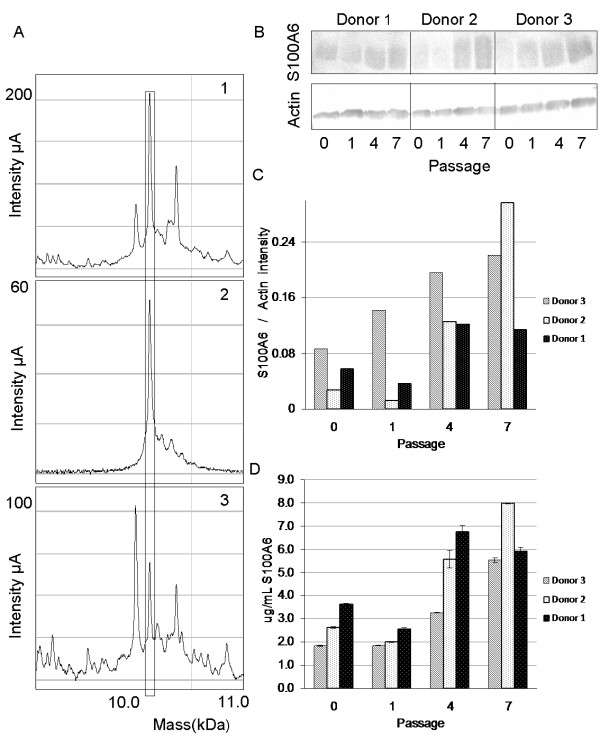
 Validation of S100A6 in cytoplasmic extract of AD-MSC. A) SELDI-ToF immunoassay of m/z 10,087. Cytoplasmic extract from a pool of AD-MSC at passage 7: 1) spotted on CM10 array; 2) spotted on PS10 array indirectly coupled to anti-S100A6 antibody; 3) eluted from PS10 array indirectly coupled to anti-S100A6 antibody and spotted on CM10 array. The signals enclosed by the rectangle represent the peak at m/z 10,087. B) SDS-PAGE/Western blot analysis using anti-S100A6 and anti-Actin antibody of AD-MSC during different passages of cell expansion for different donors. C) Western blot densitometry quantification of the corresponding S100A6. Values are expressed as relative intensity ratio between S100A6 and Actin. D) Human S100-A6 ELISA quantification. Values are expressed as absolute quantification (μg/ml S100A6).